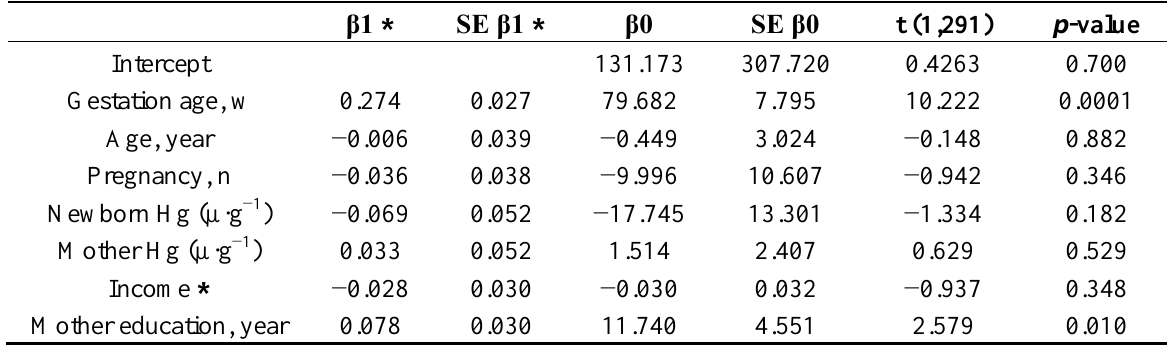
Table 2. Summary of multiple regression of chosen variables that might influence birth